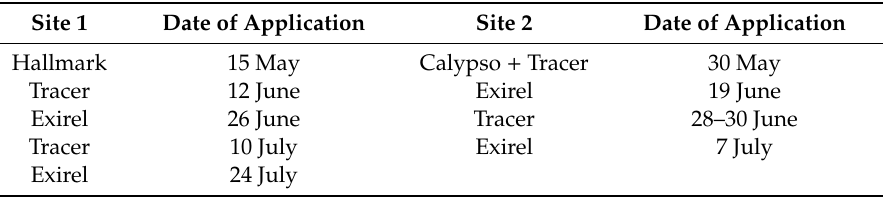
Table 5. Fortnightly spray programs and dates applied by the growers in 2018. At farm site 1 there was also a spray of Calypso (thiacloprid) on 15 April and 2 May, then Batavia (spirotetramat) on 15 May to control aphid and capsid pests; products were applied by the grower according to the label instructions at the time. At farm site 2 there was a spray of Calypso on 13 April for control of capsids, and Batavia on 15 May for aphid control. The rates used were the same as previously described